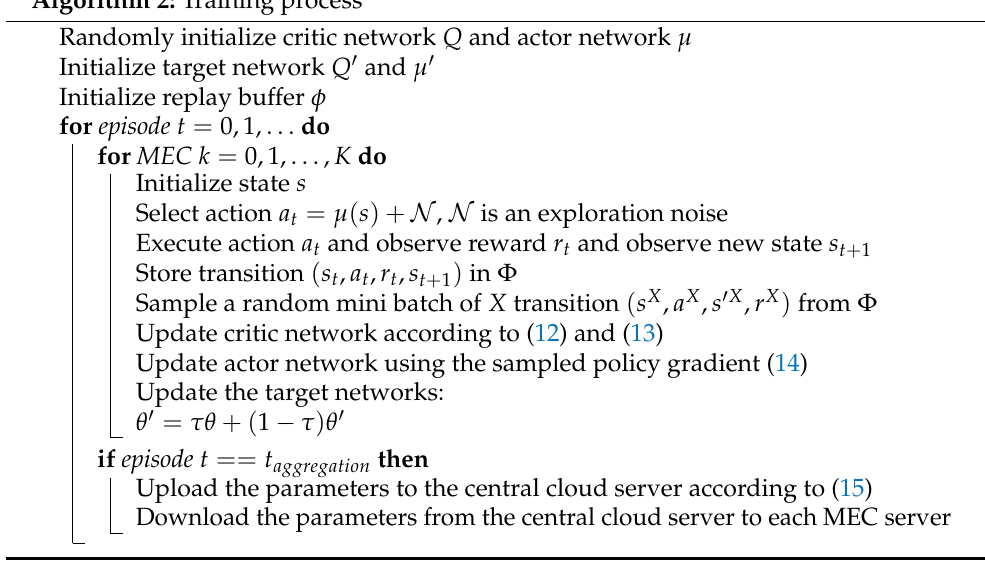
Algorithm 2: Training